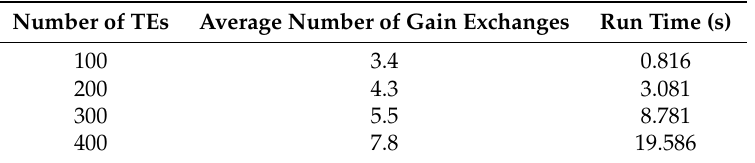
Table 2. Number of gain exchange to reach stable matching under di ff erent numbers of